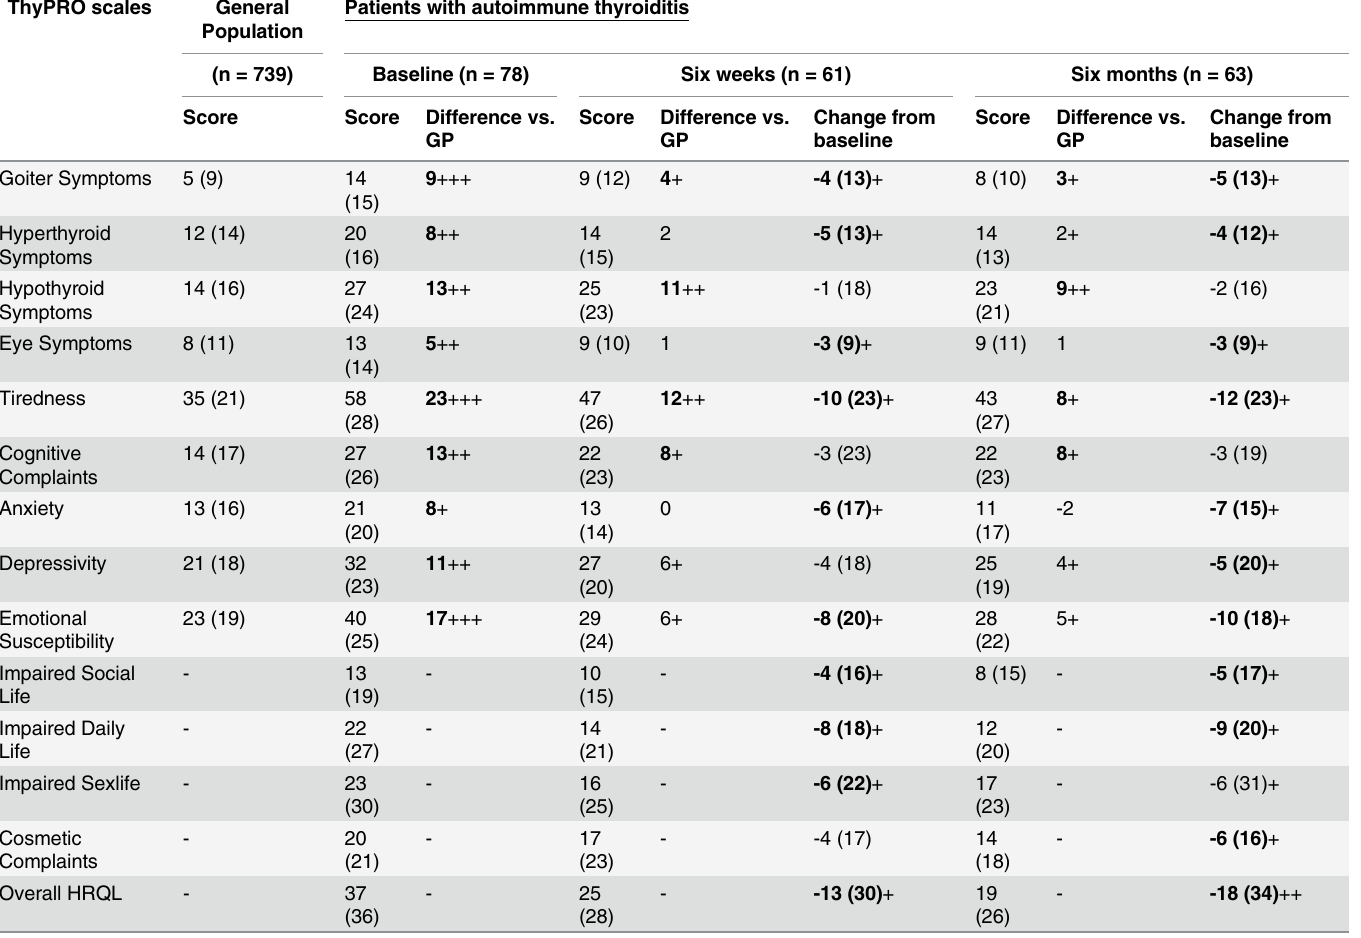
Table 2 legend and notes: Mean (SD) ThyPRO scale scores (0 – 100, higher scores indicating worse HRQL) of the general population (GP) sample and patients with autoimmune thyroiditis at baseline (before treatment) and at follow-up (six weeks and six months after initiation of LT4 therapy). Differences between patients and the general population sample were analyzed with multiple linear regression analysis, adjusting for age, sex, comorbidity, and educational status. Changes between baseline and follow-up for patients completing the questionnaire at both assessments were analyzed with the paired t-test. Discrepancies between mean scores and mean changes were due to the 15 responders lost to follow-up. Magnitudes of changes were evaluated by effect sizes (mean difference/SD baseline ). Items in fi ve ThyPRO scales (Impaired Social Life, Impaired Daily Life, Impaired Sexlife, Cosmetic Complaints, and Overall Quality of Life) are asked with attribution to thyroid disease and cannot be answered by respondents from the general population. Statistically signi fi cant differences (P < 0.05) are marked in